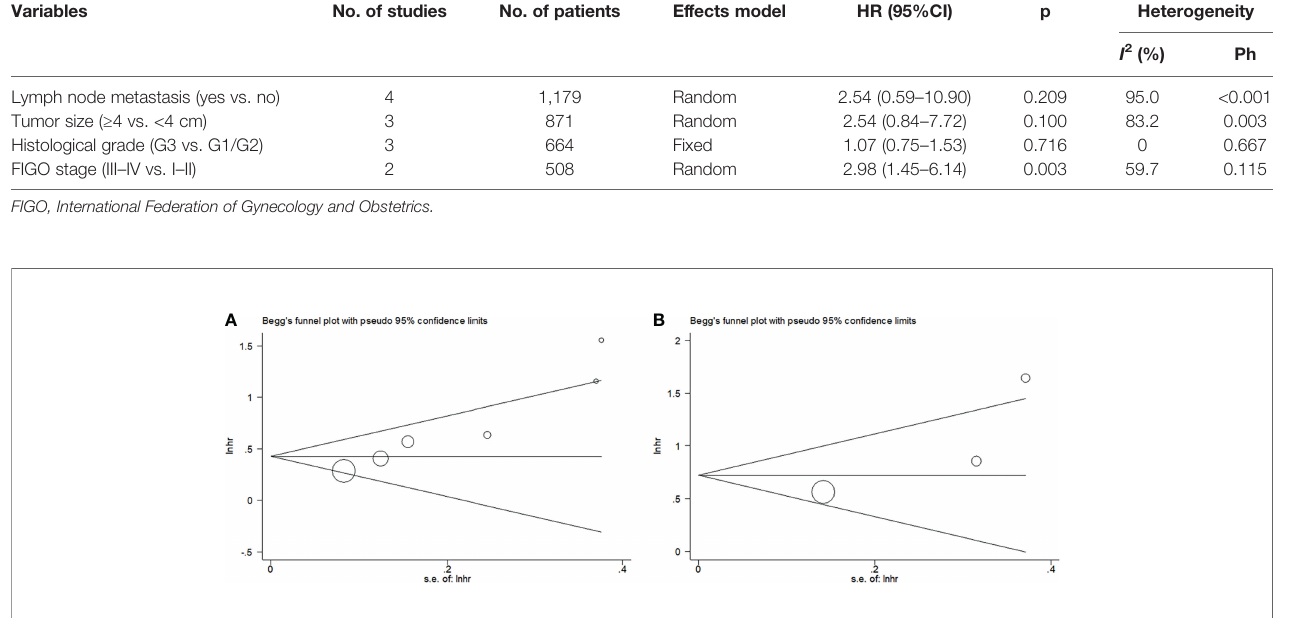
TABLE 4 | The correlation between CRP/Alb ratio and clinicopathological features in patients with gynecological cancers. Variables No. of studies